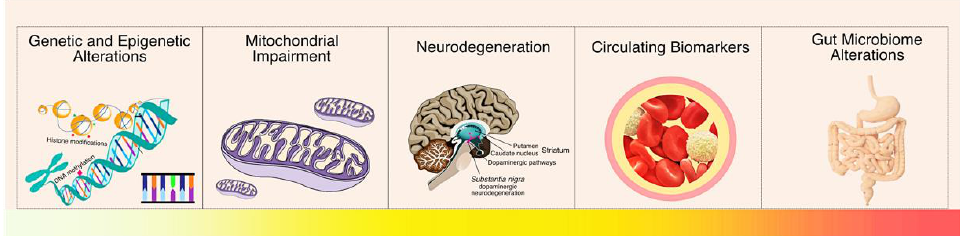
Figure 1. Molecular factors that may be involved in Parkinson’s Disease onset and progression.